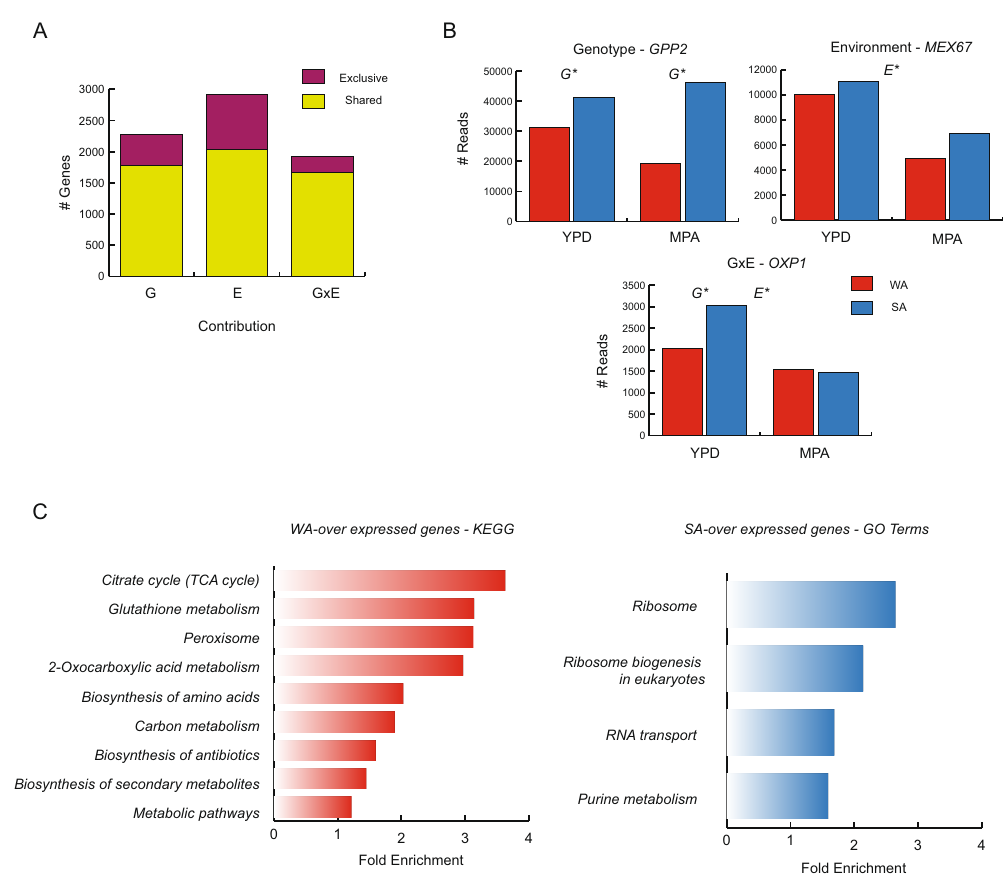
Figure 3. GxE interactions in WA and SA parental strains grown in MPA. ( A ) Number of genes exhibiting significant Genotype (G), Environment (E) and GxE (Genotype × Environment) components derived from parental expression data. The number of genes with shared (genes with more than one significant component, in yellow) and exclusive (exhibiting a sole significant component, in purple) components are depicted. ( B ) Examples of WA and SA reads in YPD and MPA for GPP2 (Genotype), MEX67 (Environment) and OXP1 (GxE) examples, (G * ) and (E * ) denote significant genotype and/or environment effects FDR < 0.05. ( C ) KEGG Pathway enrichment of WA over-expressed genes (left red panel) and SA over-expressed genes (right blue